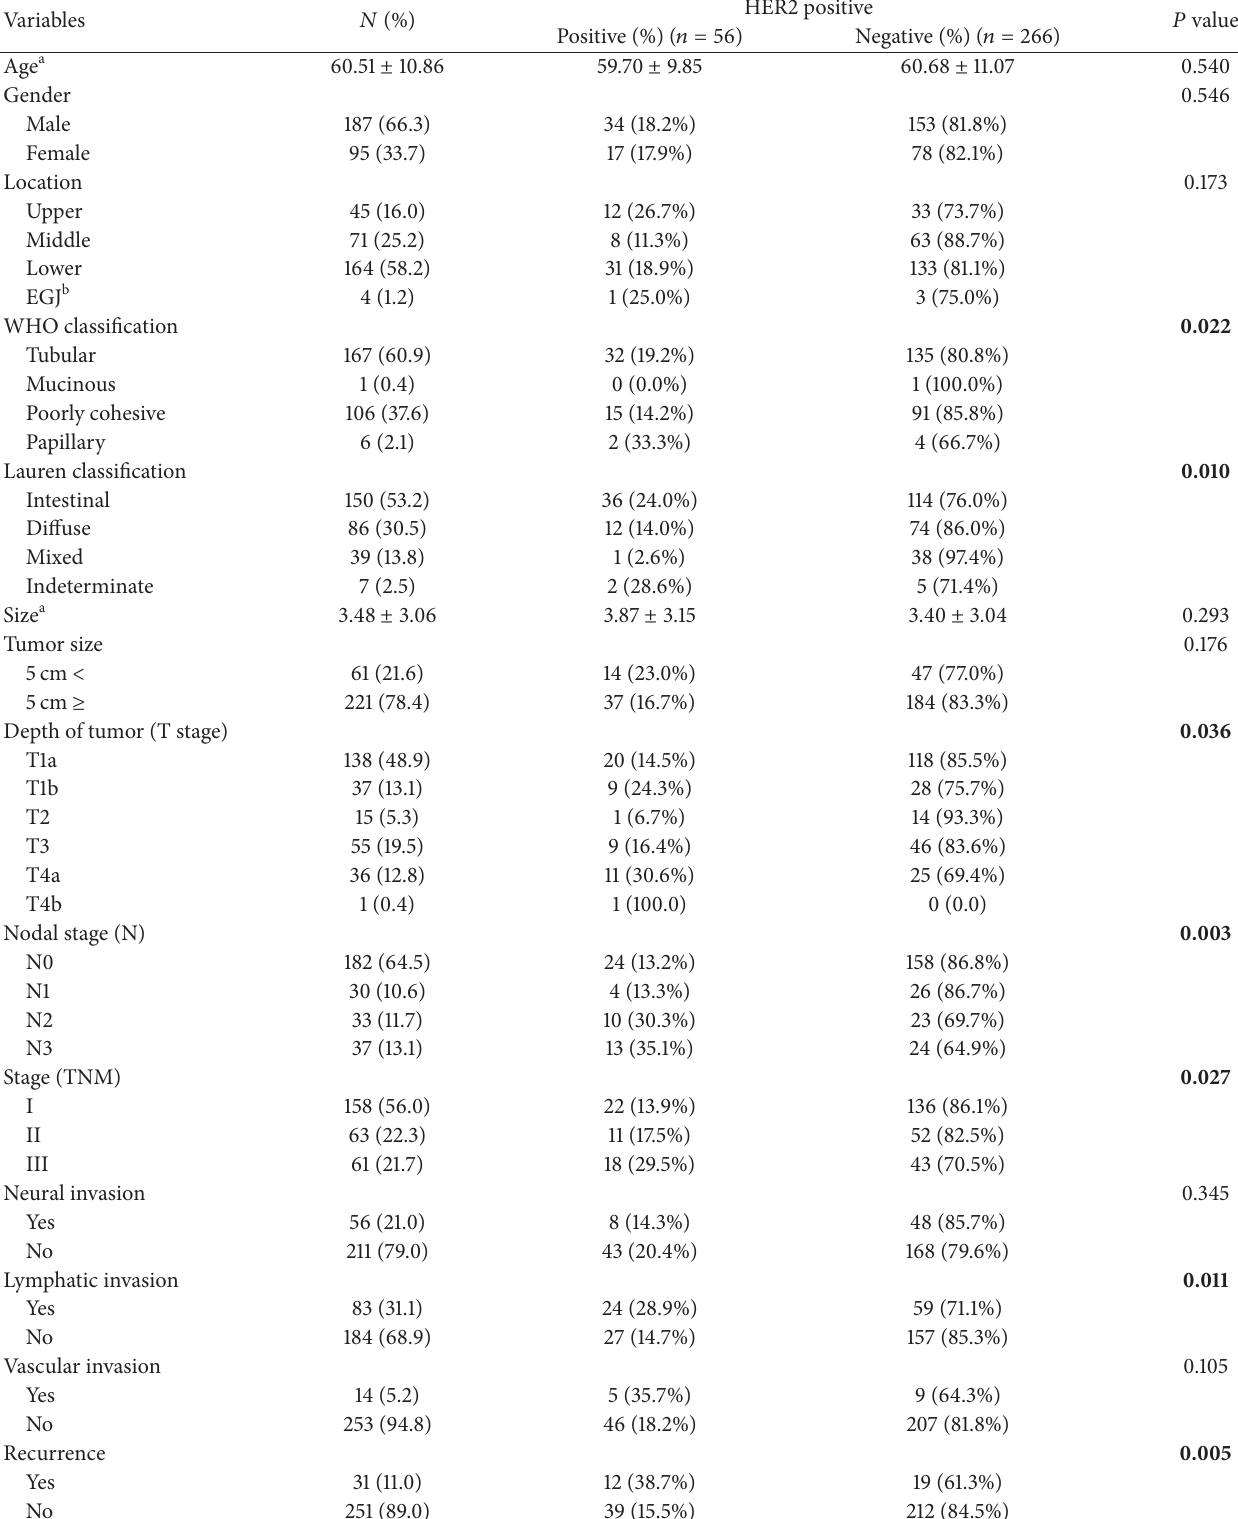
Table 1: Correlation between HER2 overexpression and clinicopathologic parameters of gastric